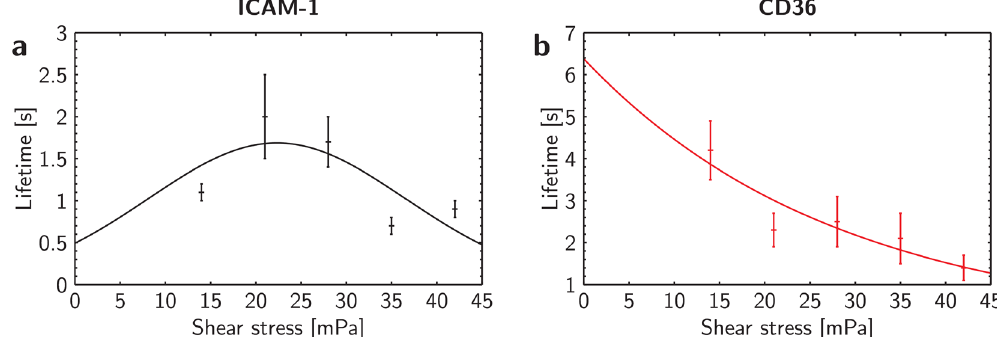
Figure 4. Multiple bond flow experiment results. Panel a: Lifetime against shear stress graphs of iRBC-ICAM-1 interactions fitted to the multiple catch bond model. Panel b: Lifetime against shear stress graphs of iRBC-CD36 interactions fitted to the multiple slip bond model. Lifetimes are represented as mean ±